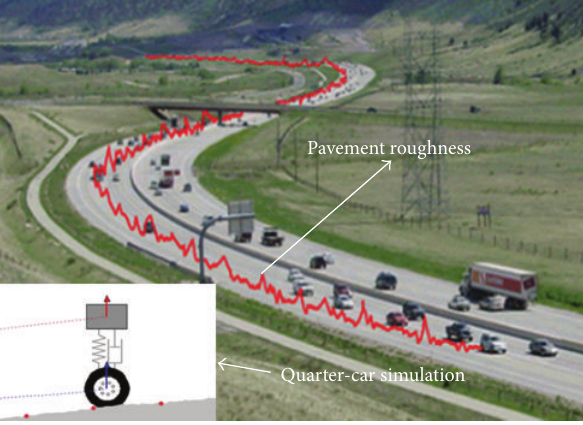
Figure 2: International roughness index (IRI) determination through measurement of pavement roughness and quarter-car sim-